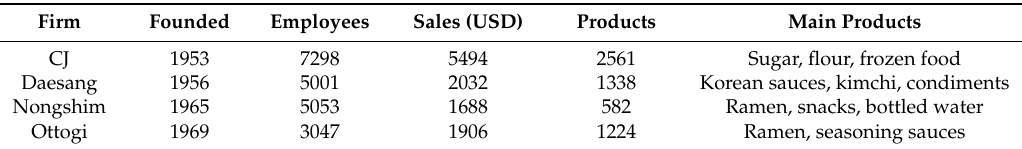
Table 2. Overview of each firm.